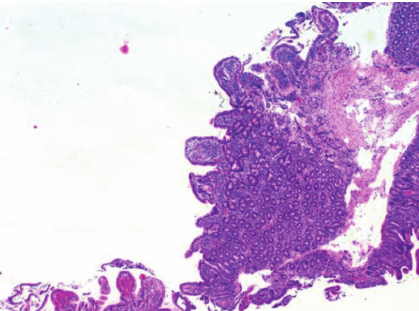
Figure 5: H&E section of jejunal biopsy showed eosinophils infiltration (30/HPF) in the lamina propria.